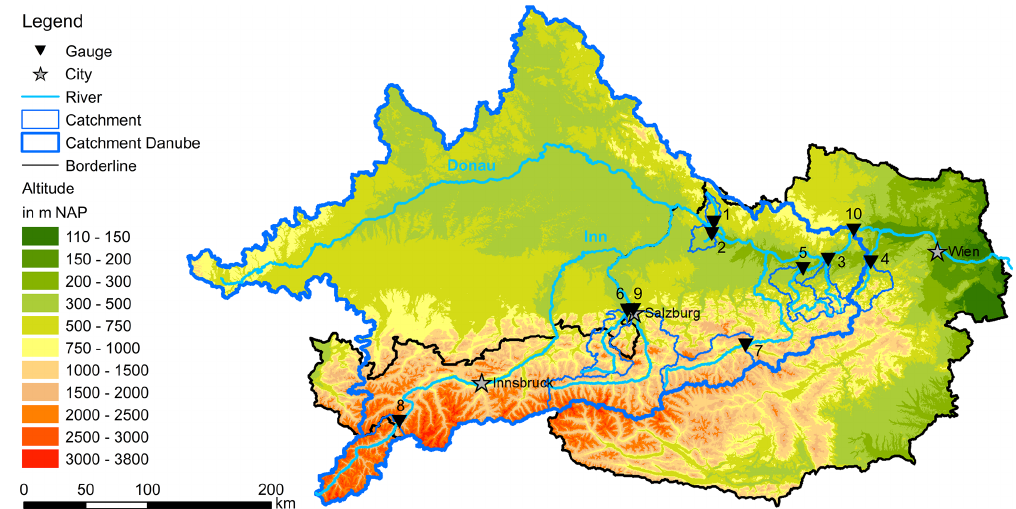
Figure 1. Study sites in Austria, Germany and Switzerland. All gauging station IDs refer to the IDs in Table 1. Delineation sources: Bayrisches Landesamt für Umwelt; HAO: Hydrological Atlas of Austria digHAO (BMLFUW, 2007). Table 1. Overview of study catchment characteristics, including means of meteorological values of catchment means ( T w , Q, T a , P , GL), catchment areas (Area), mean catchment elevations (Elevation), catchment glacier and perpetual snow cover (Glacier), available data time periods (Time period) and number of years with data (Years). IDs refer to the IDs used in Fig. 1. The percentage of glacier and perpetual snow cover was computed from the CORINE Land Cover data 2012 and the mean catchment elevation from the EU-DEM v1.1 digital elevation model with 25 × 25m